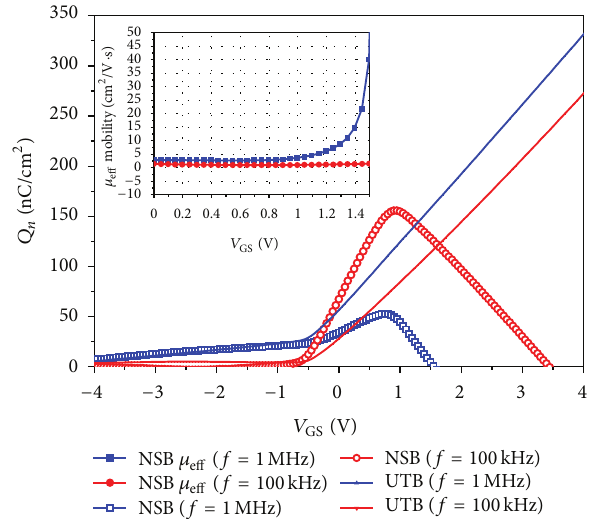
Figure 12: Representation of the mobile charge density 𝑄 𝑛 as a voltage for UTB and NSB devices (at 100kHz function of the 𝑉 GS and